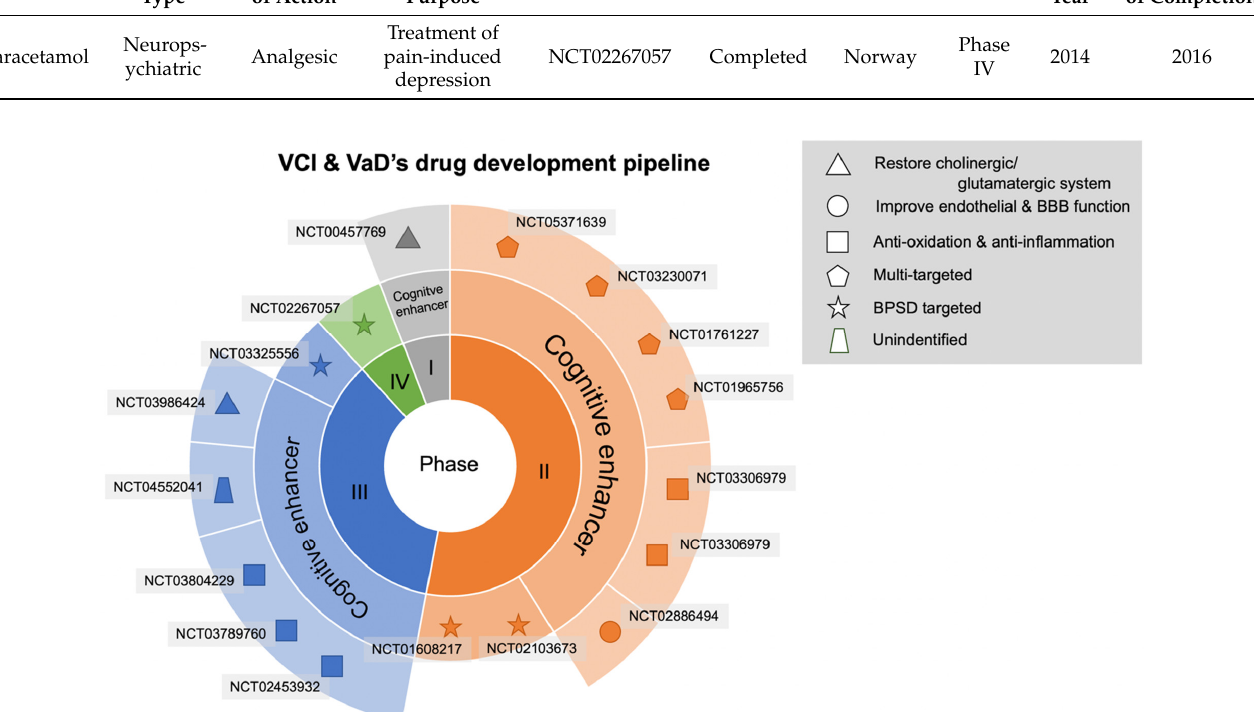
Figure 2. Drug development pipeline in VCI or VaD treatment. The agents are displayed using specific shapes corresponding to their pathophysiological mechanisms. BBB, blood–brain barrier; BPSD, behavioral and psychological symptoms of dementia . Table 1. Therapeutic agents for VCI and VaD treatment in phase III testing .